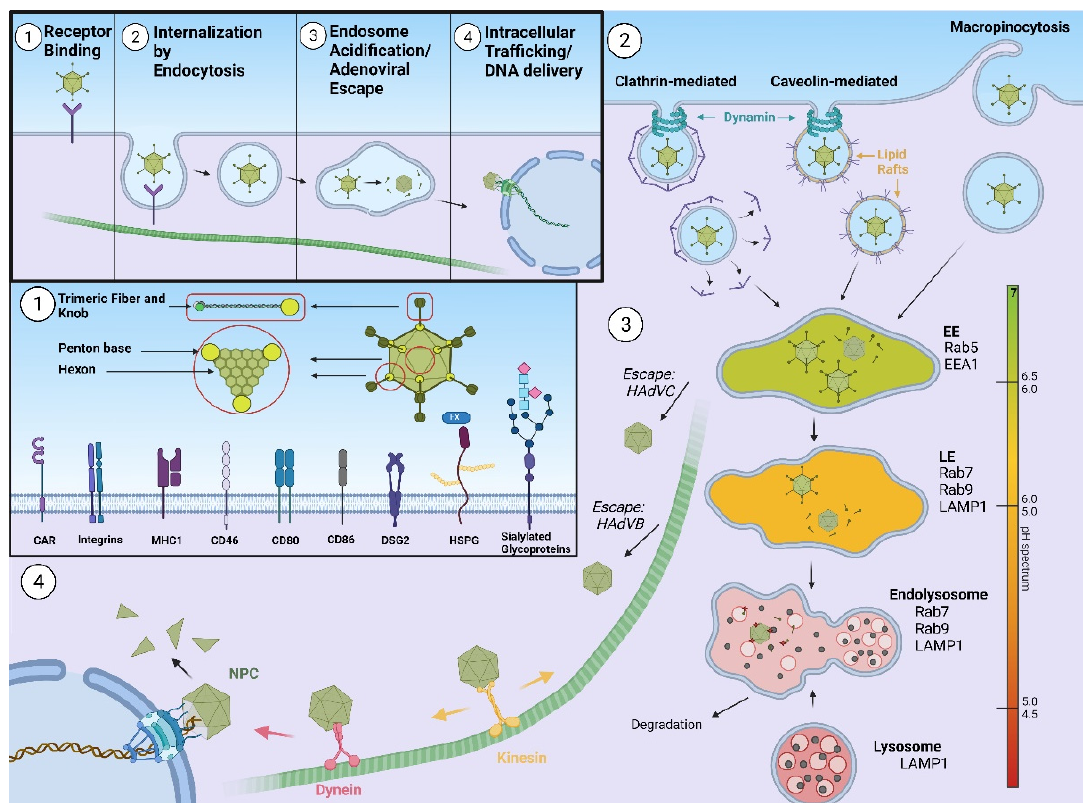
Figure 1. Schematic representation of different steps in adenovirus infection, ultimately leading to delivery of the viral genome to the host cell nucleus. 1. Adenovirus basic structure and various possible binding receptors. 2. Internalization of the virion by different mechanisms of endocytosis. 3. Virion trafficking within vesicles and endosome acidification, followed by virion escape. 4. Docking at the nuclear pore complex and delivery of the adenoviral genome. Abbreviations: CAR – coxsackie and adenovirus receptor; MHC1—major histocompatibility complex class 1; DSG2—desmoglein 2, HSPG—heparan sulfate proteoglycans, FX—factor X, EE—early endosome, LE—late endosome, EEA1—early endosome antigen 1, LAMP1—lysosomal-associated membrane protein 1, HAdVC—human adenovirus subgroup C, HAdVB—human adenovirus subgroup B, NPC—nuclear pore complex.